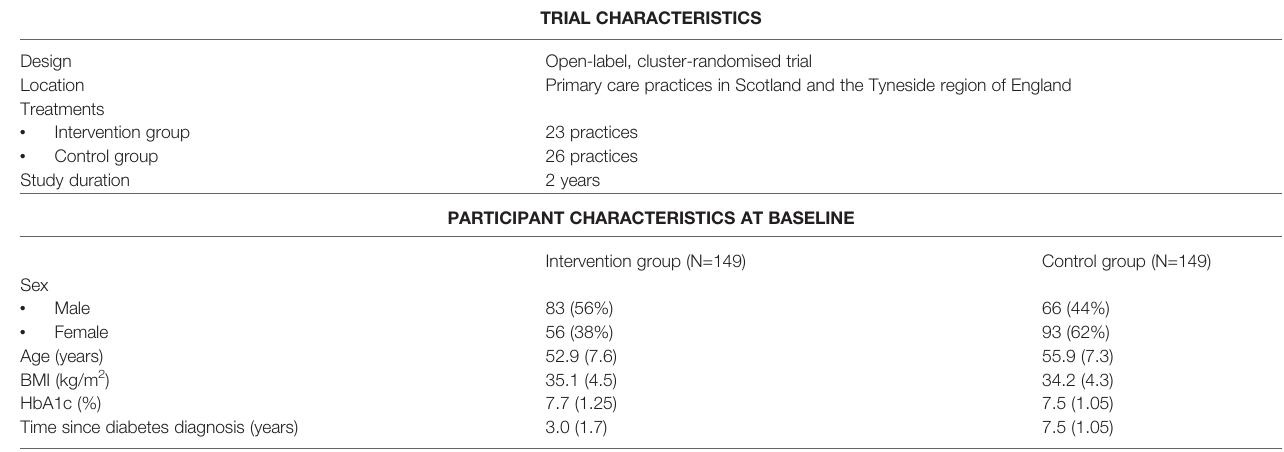
TABLE 1 | DiRECT characteristics and baseline participant